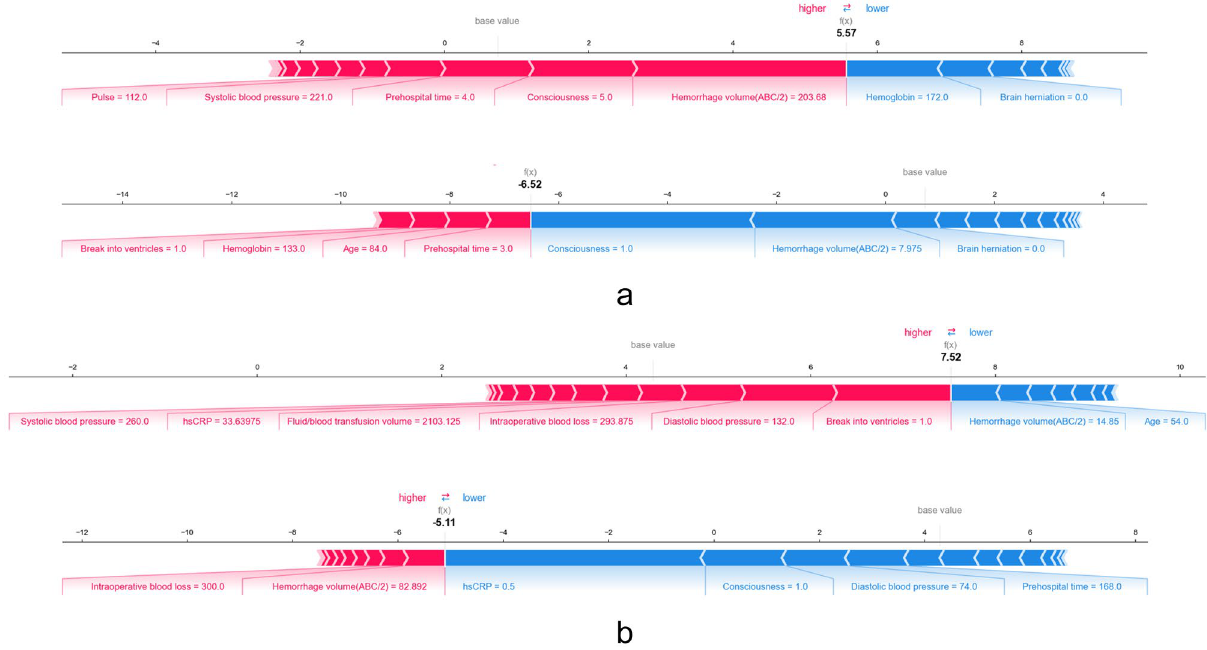
Figure 6. SHAP force plots based on individual patient prediction scores. ( a ) Low- and high-risk instances in the CTG. ( b ) Low- and high-risk instances in the STG. the base value is the mean Shap values predicted by the model, and the red and blue directed bars indicate the risk and safety features, respectively; the length of the bars represents the importance of the feature, which together drive the prediction from the base to the final value. The Shap values shown in the graph are the log odds of the true predicted